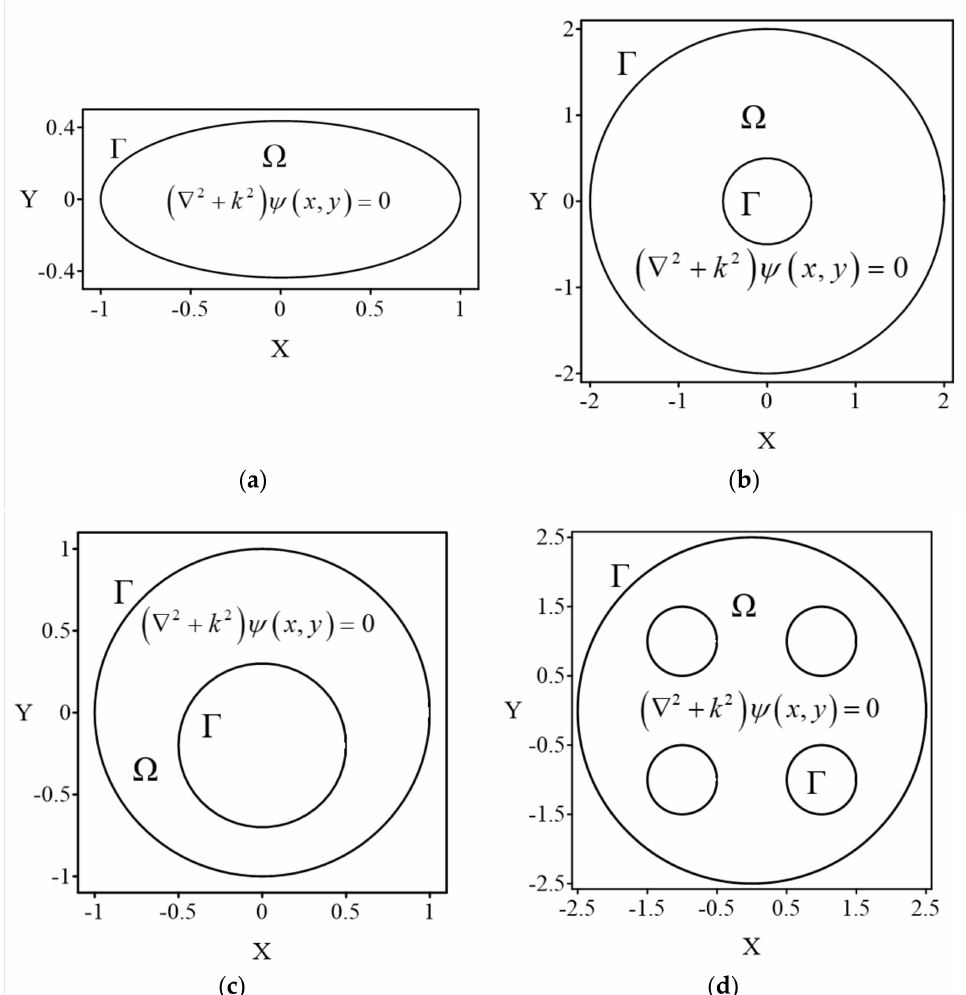
Figure 2. The computational domain and corresponding boundary for ( a ) elliptic waveguide, ( b ) concentric annular waveguide, ( c ) eccentric annular waveguide, and ( d ) multi-connected domain